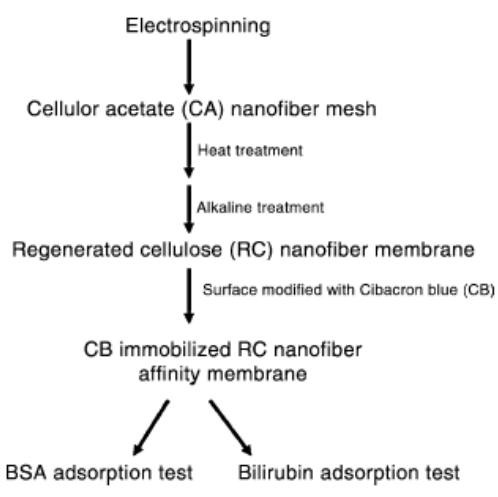
Figure 7. Schematic diagram of overall process of bio-removal by regenerated cellulose (Adapted from [13]).